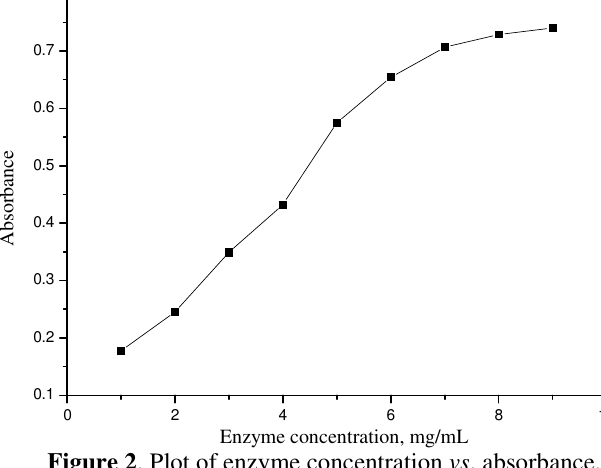
Figure 2 . Plot of enzyme concentration vs . absorbance.